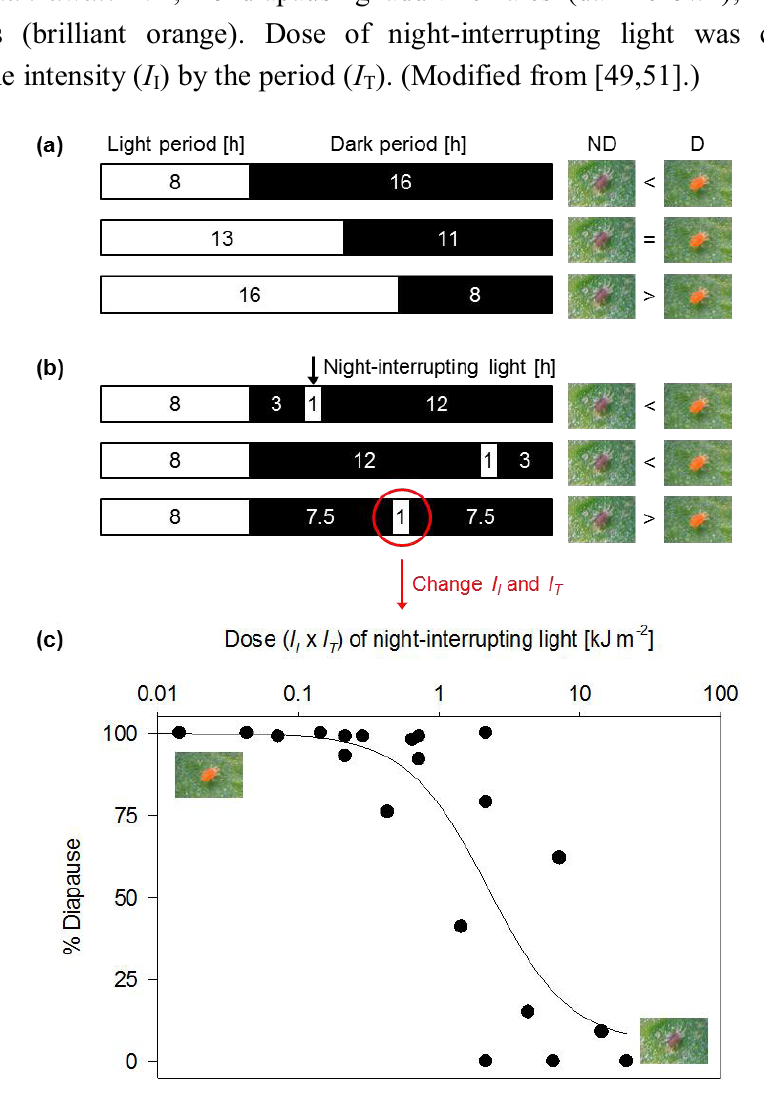
Figure 2. Effects of (a) extending the light period, (b) the timing of a 1-h night-interrupting light, and (c) the dose of night-interrupting light applied in the middle